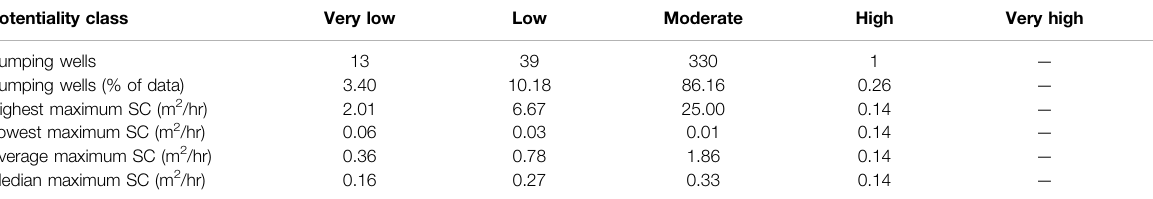
TABLE 7 | GRP map validation using SPC data.